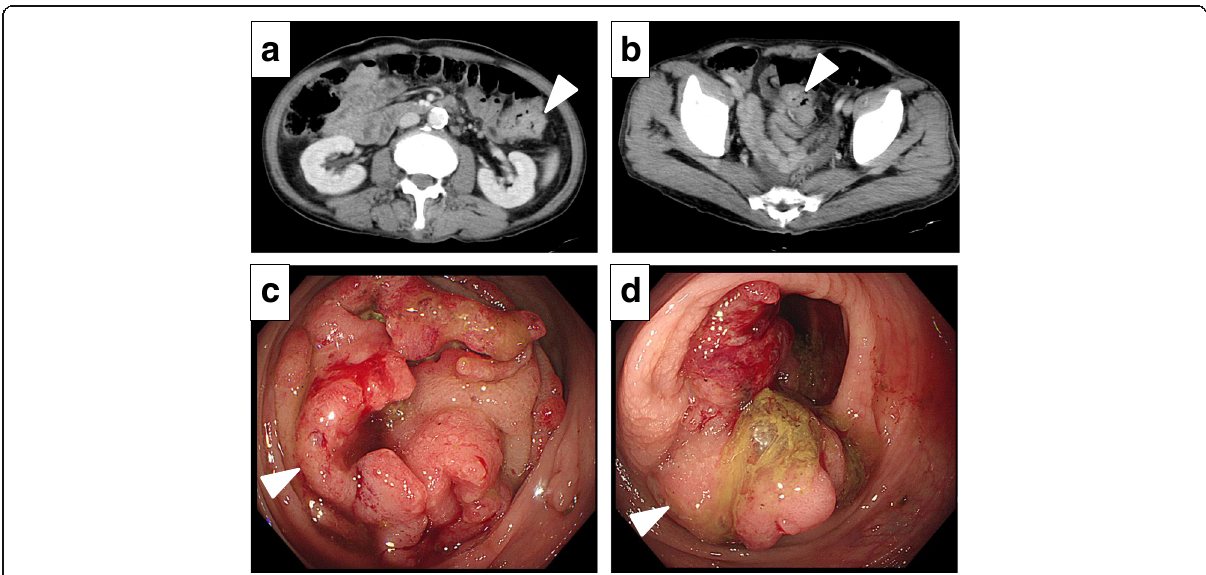
Fig. 2 Examination images of the colon cancers before the operation. a Abdominal computed tomography revealing an enhancing mass in the sigmoid colon ( white arrow head ). b A second enhancing mass was identified in the descending colon ( white arrow head ). c Colonoscopy revealing sigmoid colon cancer ( white arrow head ). d Synchronous descending colon cancer ( white arrow head